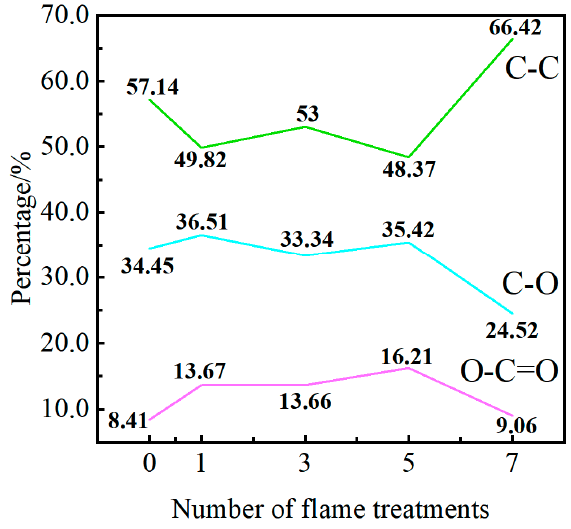
Figure 21. C 1S peak fitting results before and after surface treatment.